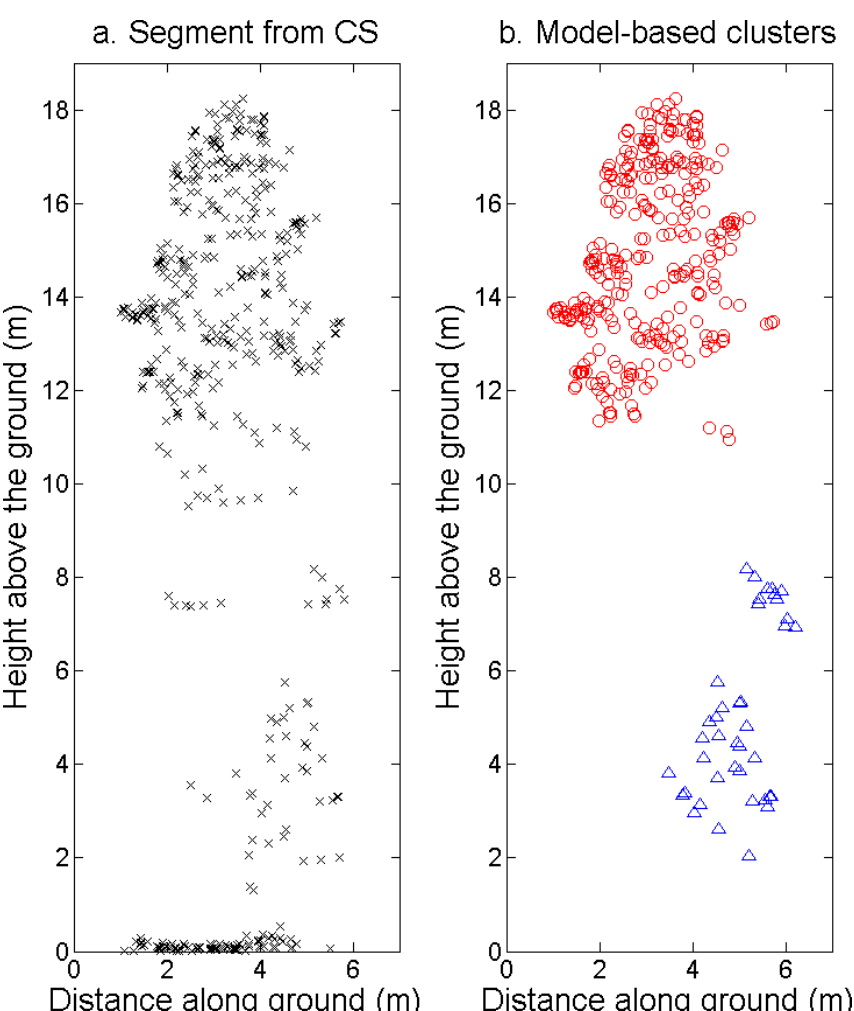
Figure 6. Side view of ALS returns assigned to ( a ) one segment delineated from the CS and ( b ) two different clusters from the tree model clustering. ALS returns assigned to other clusters are not shown